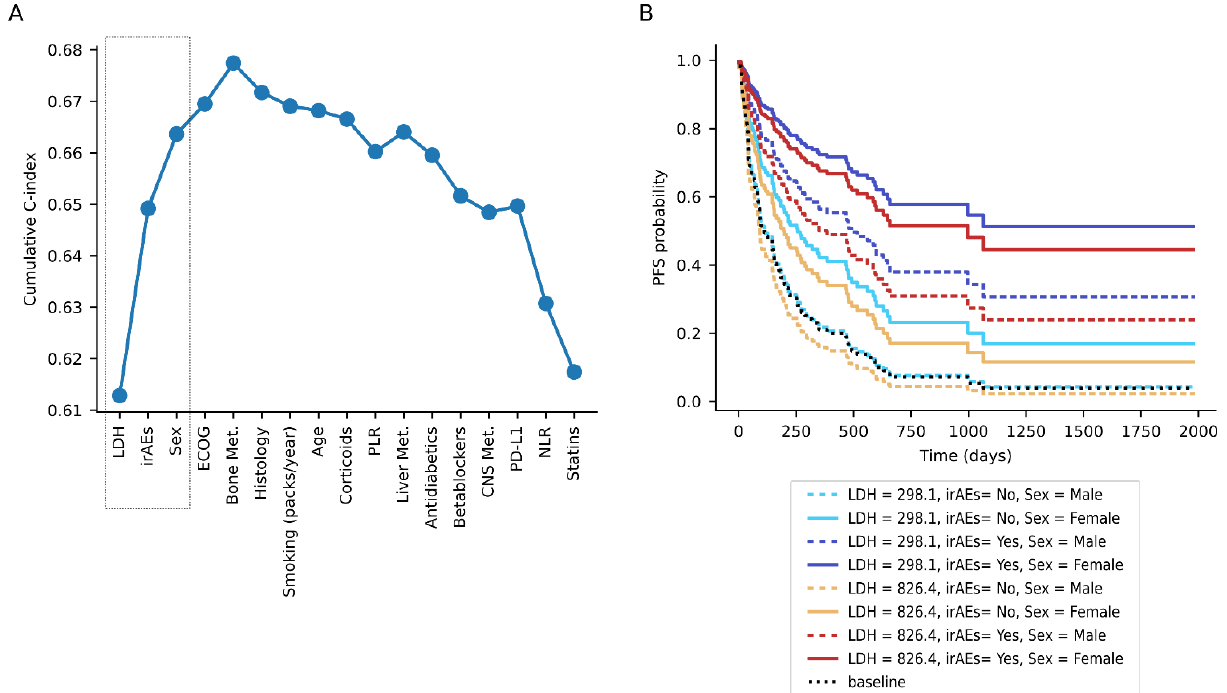
Figure 2. Compendium of features to predict ICIs benefit by maximizing non-redundant information. ( A ) Cumulative concordance index of multivariate Cox proportional-hazards models in which features have been iteratively added. The dotted rectangle encompasses the three features selected to construct the compendium. ( B ) Partial effects representation of the effect of varying the value of LDH, irAEs, or sex in a multivariate Cox proportional-hazards survival model constructed with these three features.